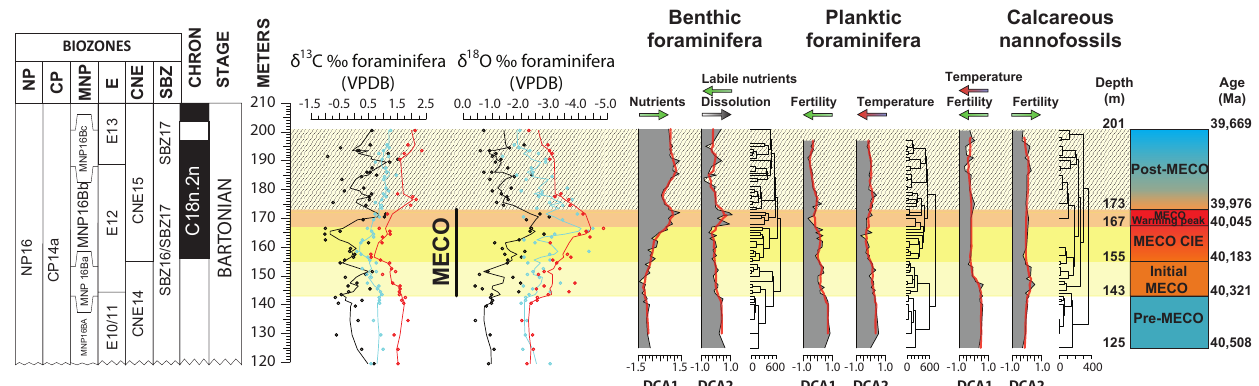
Figure 7. Changes in fertility, nutrients, temperature and carbonate dissolution as derived from the DCA analysis plotted next to the carbon and oxygen stable isotope curves. The inferred paleoenvironmental scenario for each phase is discussed in the text. Magneto-biostratigraphy and lithostratigraphy as in Figure